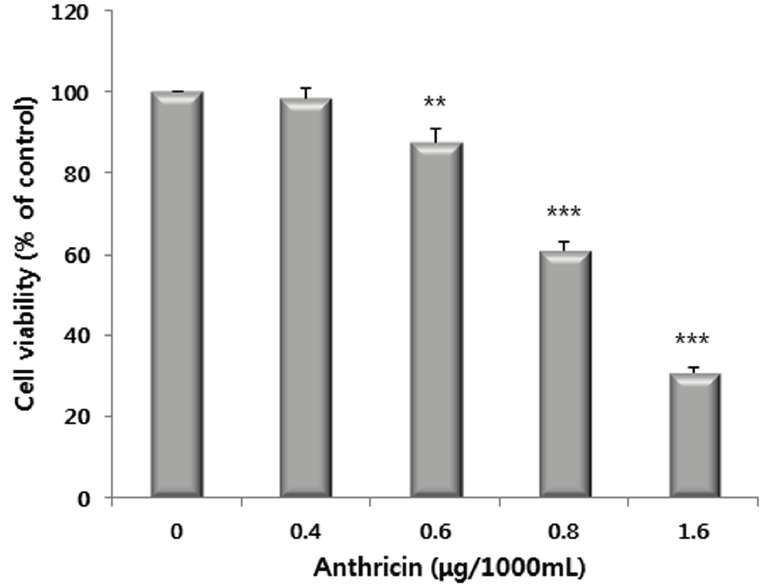
Figure 5. Effects of anthricin on cell proliferation in HCT116 human colon cancer